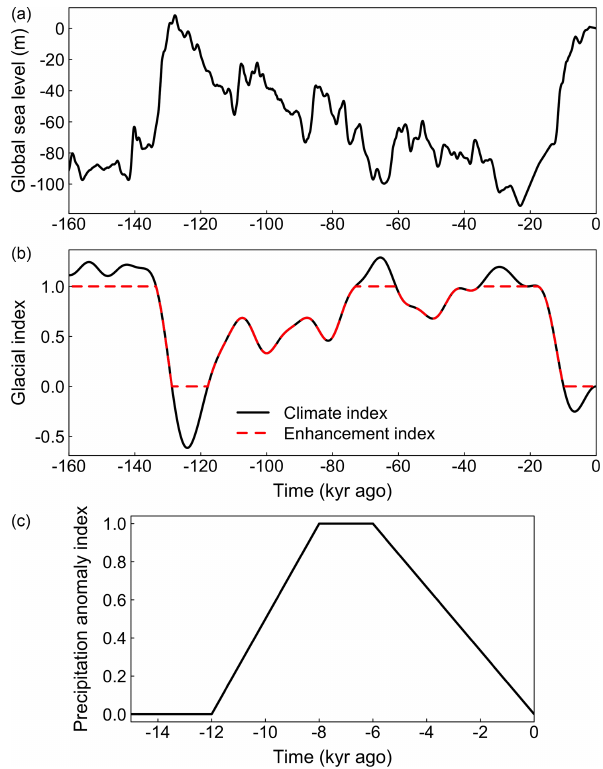
Figure 1. Forcing applied to the simulations. (a) Global sea-level anomaly relative to present day. (b) Glacial indices derived from reconstructed paleo-temperature anomalies over Greenland. The glacial climate index is used to interpolate between the LGM cli- mate snapshot and the present-day climate. The glacial enhance- ment index is used to interpolate between the imposed enhance- ment factor for ice during glacial periods and interglacial peri- ods. (c) Holocene precipitation anomaly index scales the imposed (cid:49)P hol parameter in time to ensure the maximum Holocene precip- itation anomaly occurs during the mid-Holocene